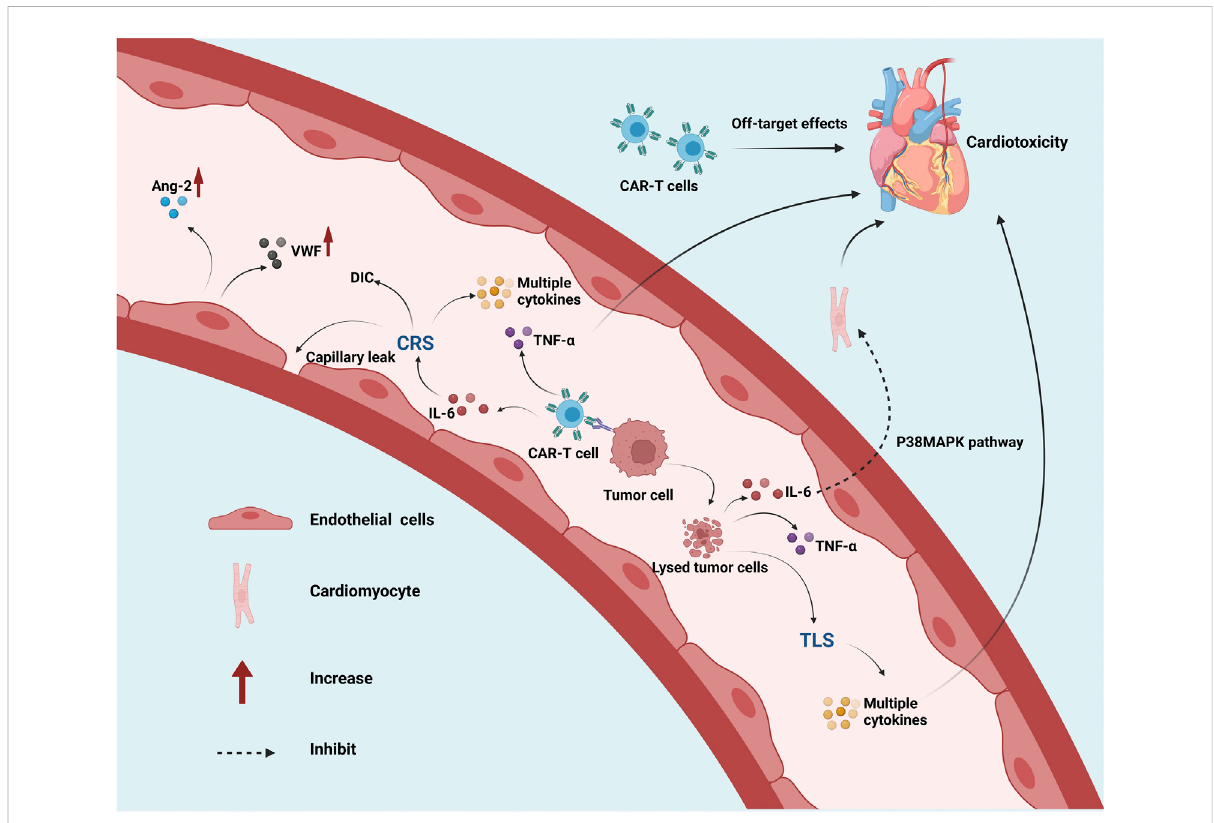
FIGURE 3 Pathogenesis ofcardiovasculartoxicityduringCAR-Ttherapy.Abbreviations:CAR,chimericantigenreceptor;CRS,cytokinereleasesyndrome; IL, interleukin; TNF- α , tumor necrosis factor alpha; MAPK, mitogen-activated protein kinase; TLS, tumor lysis syndrome; DIC, disseminated intravascular coagulation; Ang-2, angiopoietin-2; VWF, von willebrand factor. This fi gure created with